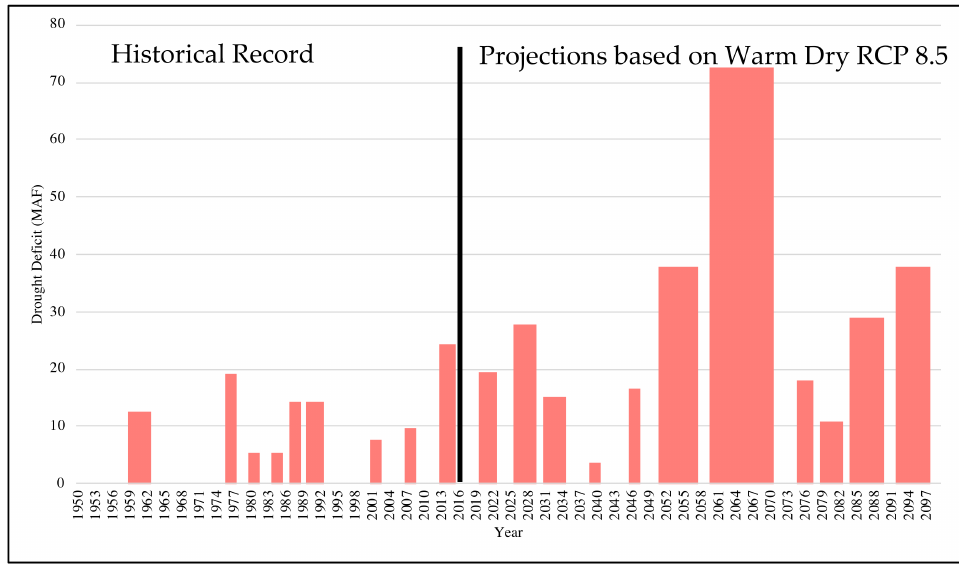
Figure 2. Yuba River drought deficit quantities for historical (1950–2015) and Warm Dry RCP 8.5 (2020–2099). The width of each bar represents the length of drought and the height of each bar represents the deficit (or magnitude) of the drought. (Note: 1 MAF = 1233 million cubic